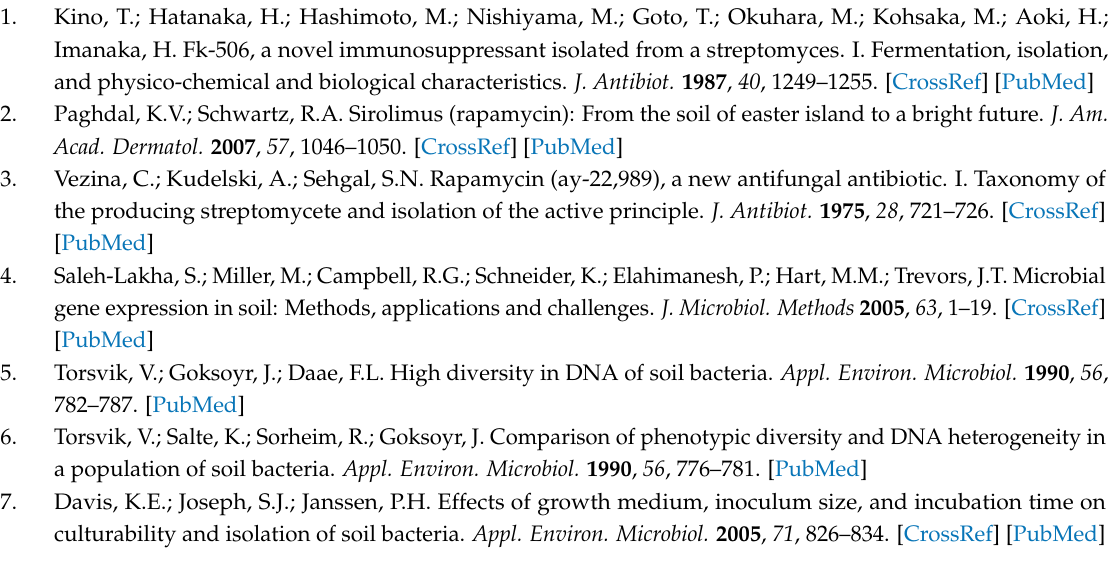
Figure S1: Vector TRIP 3.0, Figure S2: Violacein as a model of a pro-apoptotic natural product, Figure S3: Effect of bacterial delivery of Violacein into Vero cells at MOI of 10, Figure S4: Caspase 8 staining of DH10B-VioA-E infected HeLa S3 cells, Figure S5: Effect of 10 µ M purified violacein on HeLa S3 cells after a 10-h incubation, Figure S6: Sorting of HeLa S3 treated within monoclonal droplets, Figure S7: P19 EC cell aggregates generated by incubation in microfluidic droplets, Video S1: Generation of monoclonal droplets. For the purpose of the video, a concentrated solution of E. coli DH10B was encapsulated into 75 µ m microfluidic droplets, Video S2: Merging of a monoclonal library with freshly encapsulated HeLa S3 cells using an electro-fusion module. The bacteria in this video carry a Red Fluorescent Protein reporter for visualization purpose, Video S3: Generation of P19 EC aggregates using microfluidic droplets, Video S4: Merging of a monoclonal library with encapsulated P19